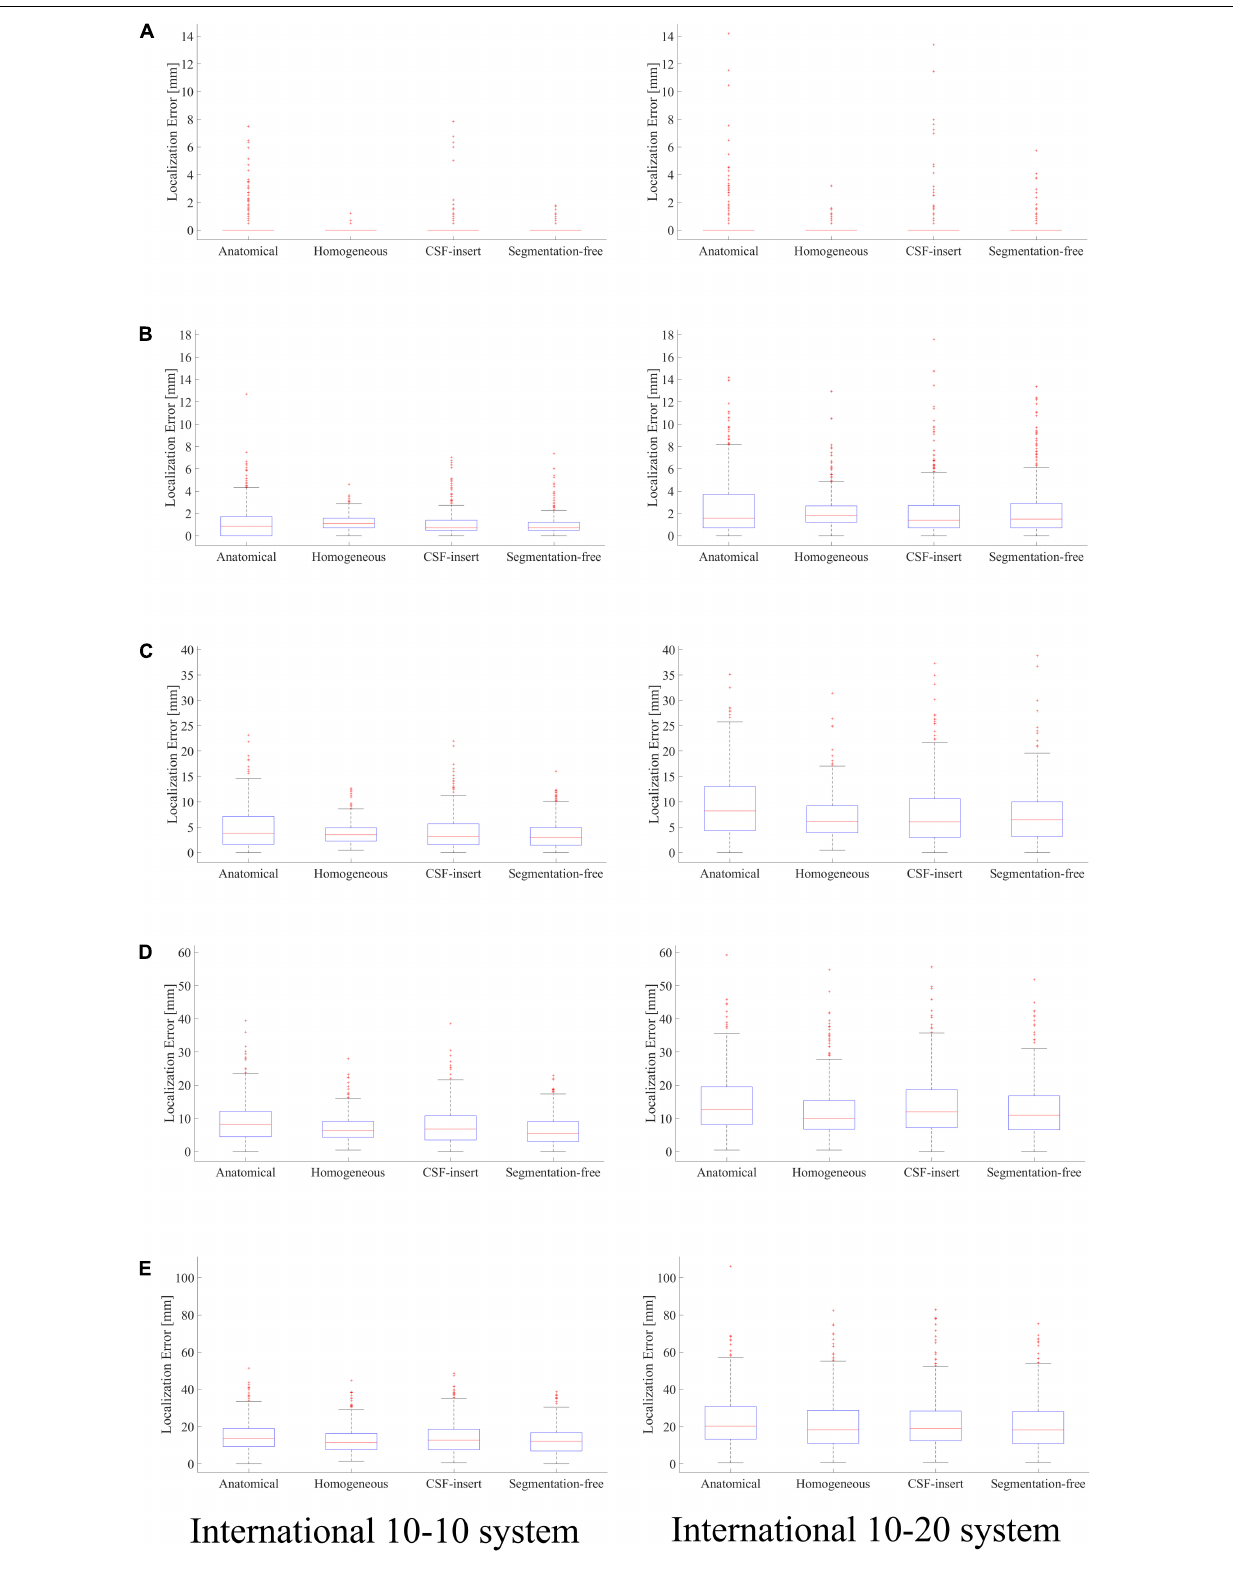
Frontiers in Neuroscience |